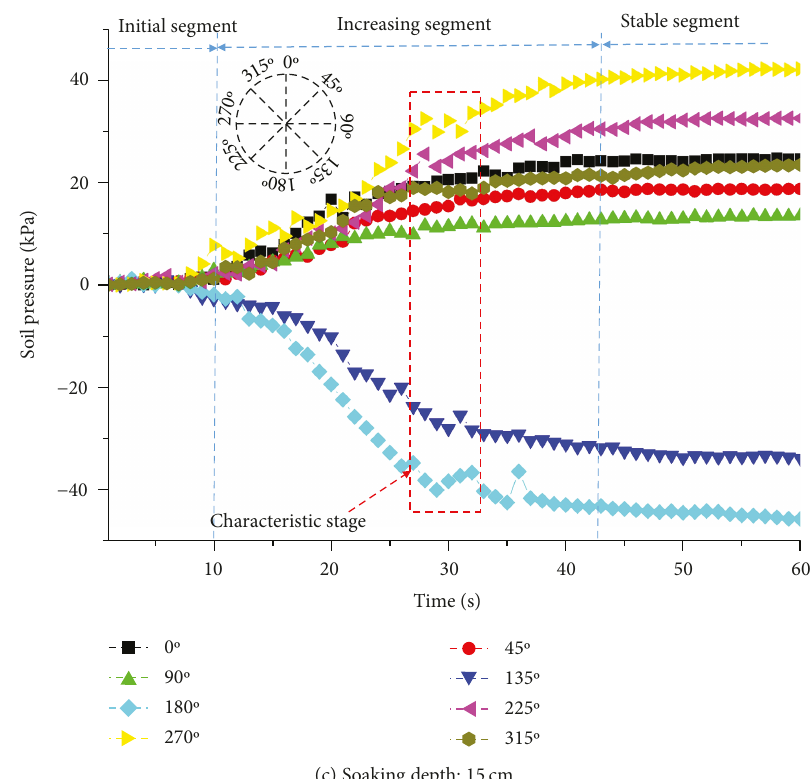
Figure 8: Soil pressure of half-range soaking with operating time.